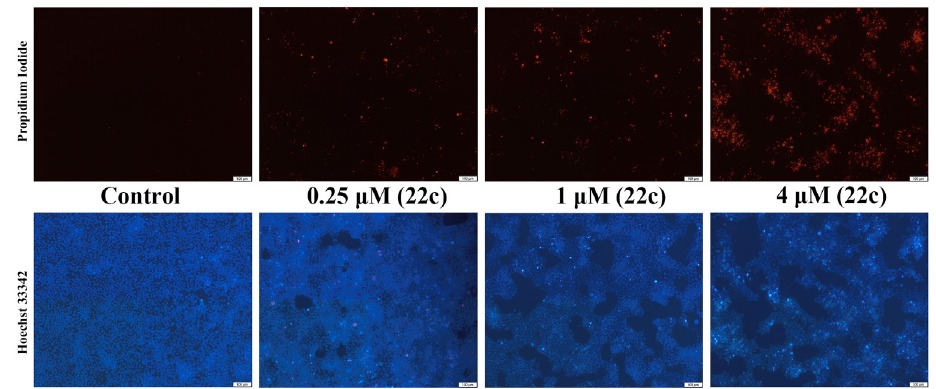
Figure 5. Flow cytometry analysis of cell cycle arrest of HCT-116 cells via PI staining after treatment with compound 22c at indicated concentration for 24 h.